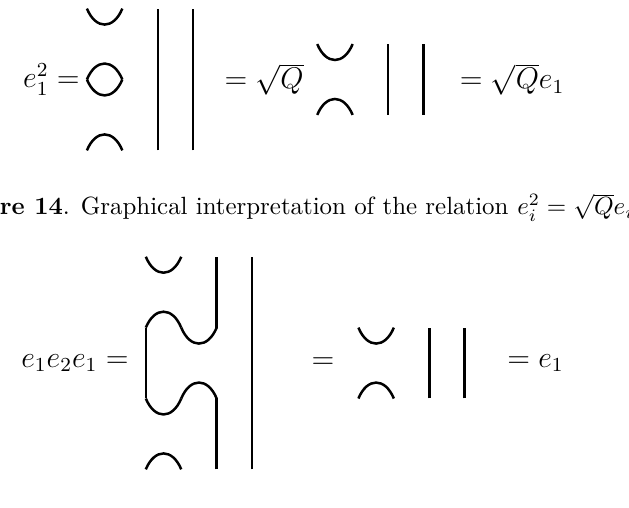
Figure 15 . Graphical interpretation of e 1 e 2 e 1 = e 1 .